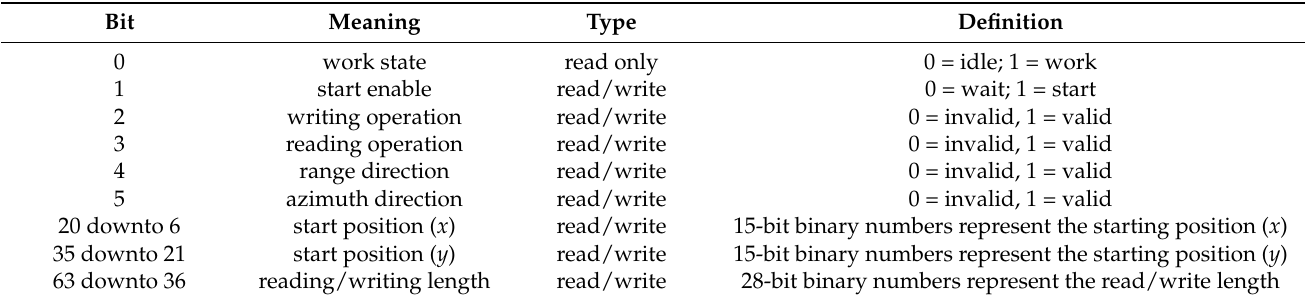
Table 3. Bit definition of the register.